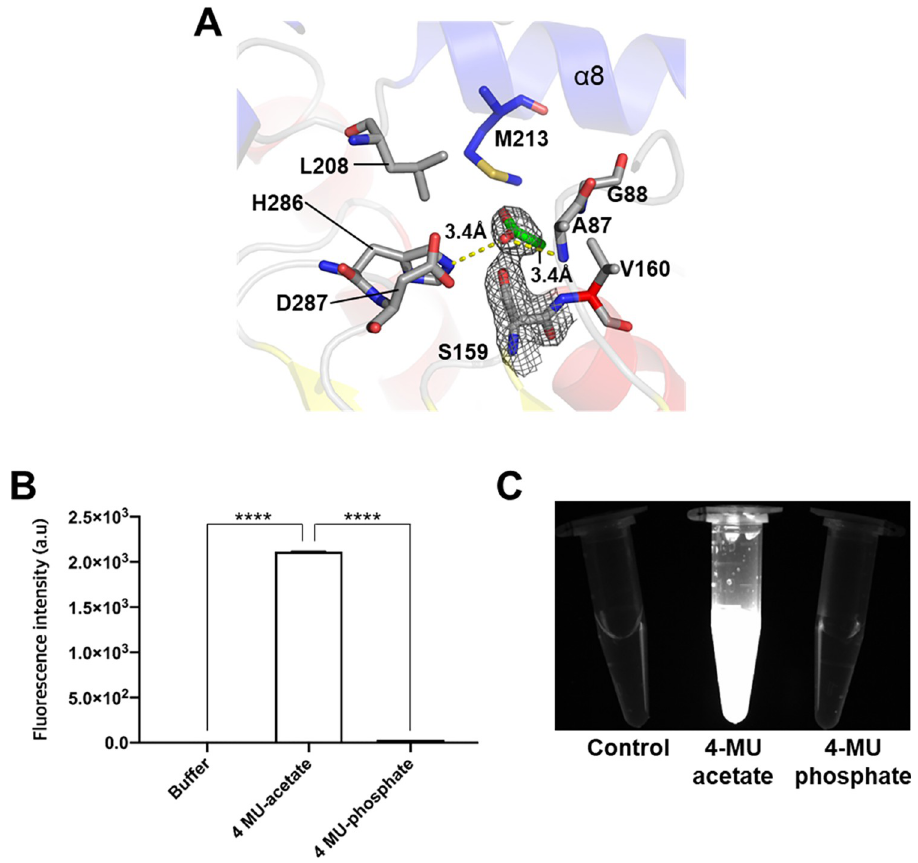
Fig 5. Active site and substrate specificity of Lg EstI. (A) A close-up view of the active site illustrating the coordination between the active site residues and the acetate moiety connected to nucleophilic S159. Hydrolysis